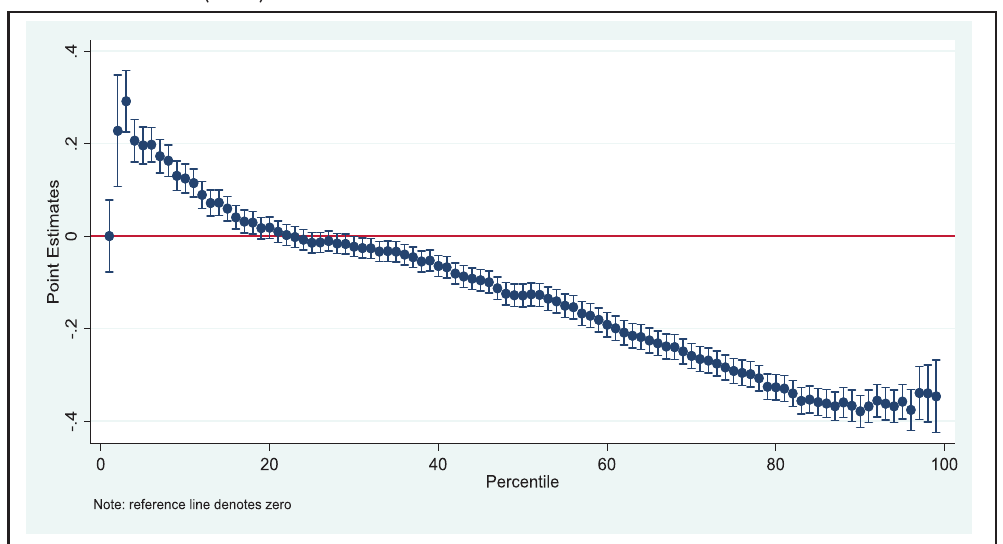
Figure 6 Point Estimates and 95% Confidence Intervals for Quantile Conflict Treatment Effects